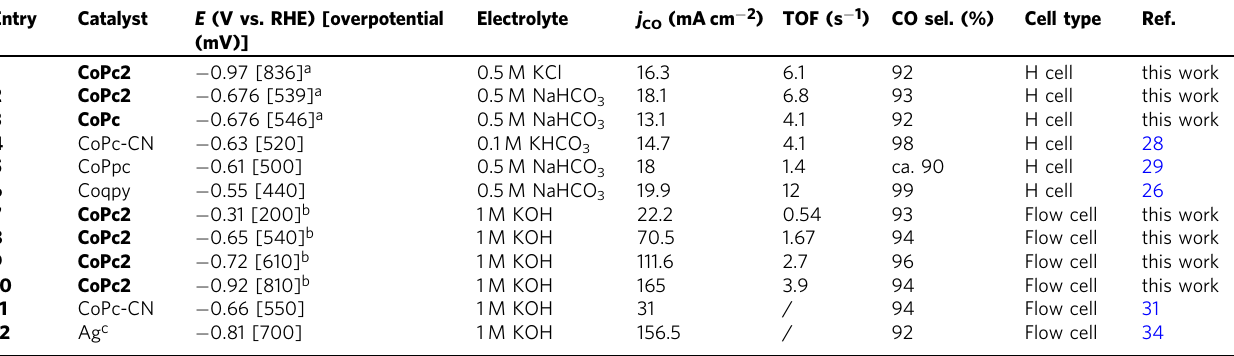
Table 2 Comparison of electrolysis performances between CoPc2@carbon powder hybrid catalyst and previously reported state- of-the art immobilized molecular Co catalysts and Ag